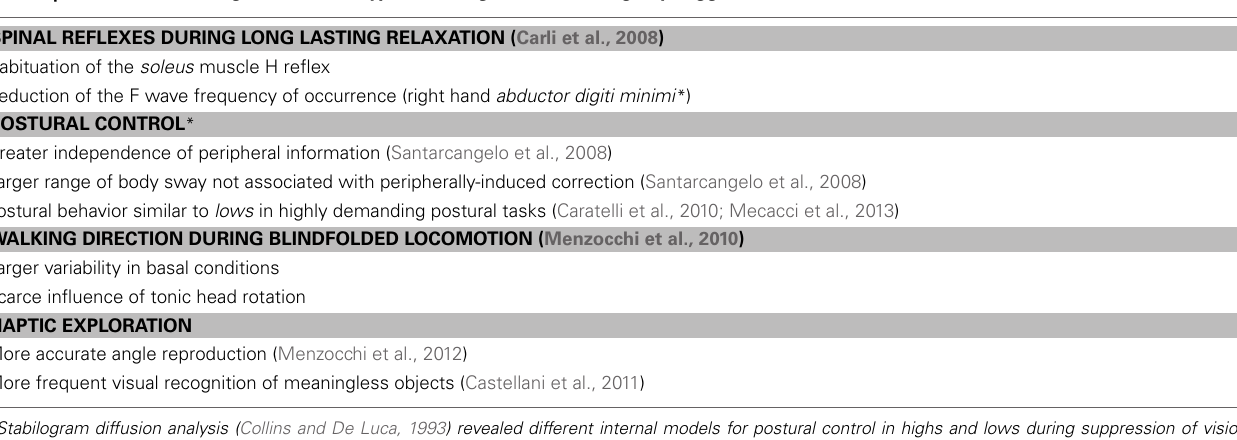
Table 1 | Sensori-motor integration in not hypnotized highs not receiving any